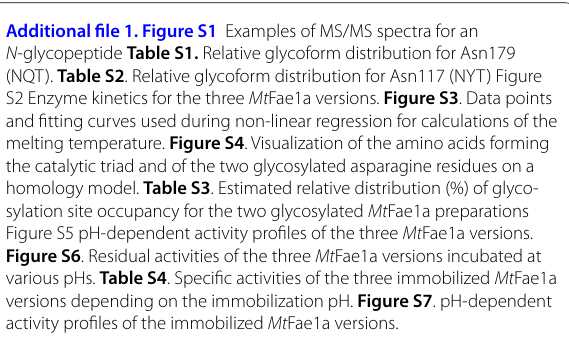
Additional file 1. Figure S1 Examples of MS/MS spectra for an N ‑glycopeptide Table S1. Relative glycoform distribution for Asn179 (NQT). Table S2 . Relative glycoform distribution for Asn117 (NYT) Figure S2 Enzyme kinetics for the three Mt Fae1a versions. Figure S3 . Data points and fitting curves used during non‑linear regression for calculations of the melting temperature. Figure S4 . Visualization of the amino acids forming the catalytic triad and of the two glycosylated asparagine residues on a homology model. Table S3 . Estimated relative distribution (%) of glyco‑ sylation site occupancy for the two glycosylated Mt Fae1a preparations Figure S5 pH‑dependent activity profiles of the three Mt Fae1a versions. Figure S6 . Residual activities of the three Mt Fae1a versions incubated at various pHs. Table S4 . Specific activities of the three immobilized Mt Fae1a versions depending on the immobilization pH. Figure S7 . pH‑dependent activity profiles of the immobilized Mt Fae1a versions. Abbreviations CV: column volume; DMSO: dimethyl sulfoxide; EIC: extracted ion chromato‑ graph; FAE: feruloyl esterase; His 6 ‑tag: hexa histidine tag; IEX: ion exchange chromatography; LC: liquid chromatography; LB: lysogeny broth; MCA: methyl caffeate; MFA: methyl ferulate; M p CA: methyl p ‑coumarate; MPS: